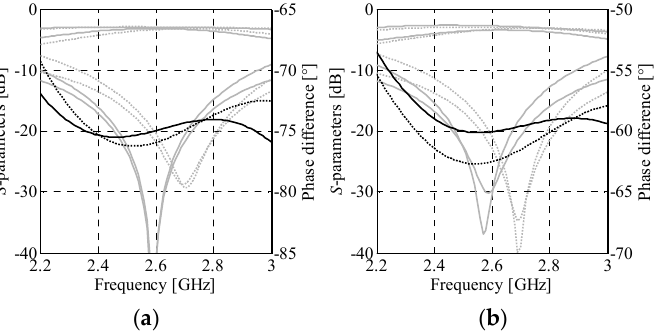
Figure 7. Compact BLC with flexible phase difference: ( a ) individual sections of the structure and ( b ) geometry of the assembled circuit. Figure 8. EM model responses of miniaturized BLC structures – magnitude (gray) and phase (black) at the initial (····) and optimized (––) designs: ( a ) BLC 1 (realized phase difference β 1 = −75°) and ( b ) BLC 2 (realized phase difference β 2 = −60°).